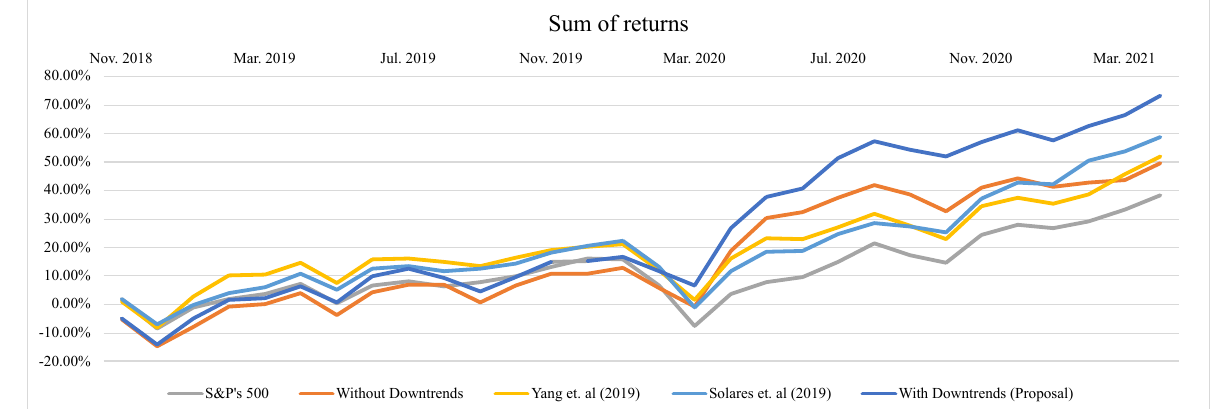
Figure 3. Sum of returns